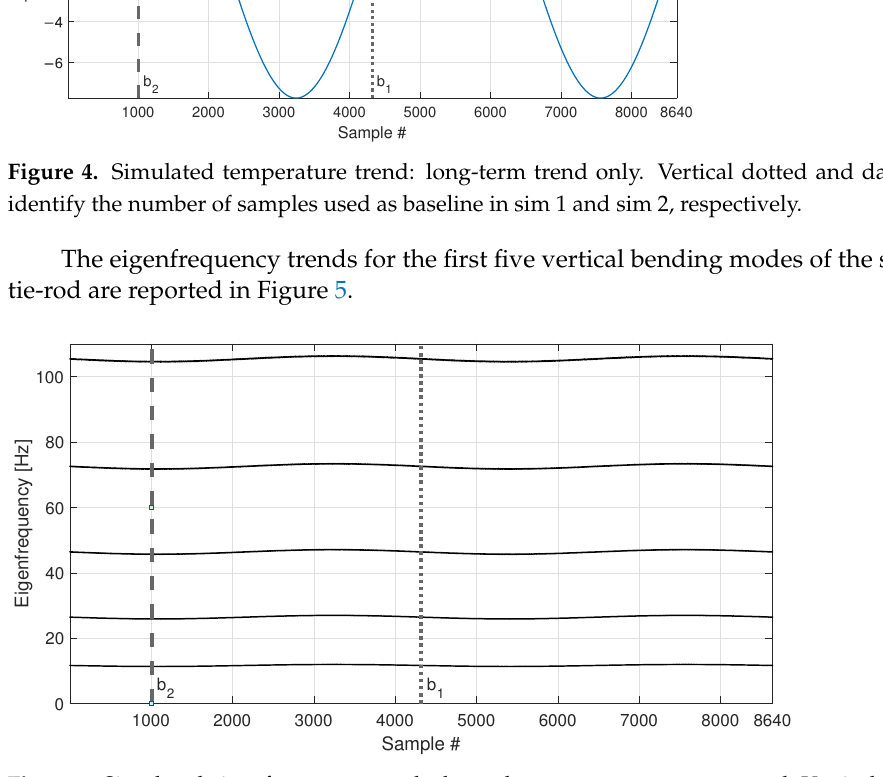
Figure 5. Simulated eigenfrequency trends due to long-term temperature trend. Vertical dotted and dashed lines identify the number of samples used as baseline in sim 1 and sim 2,